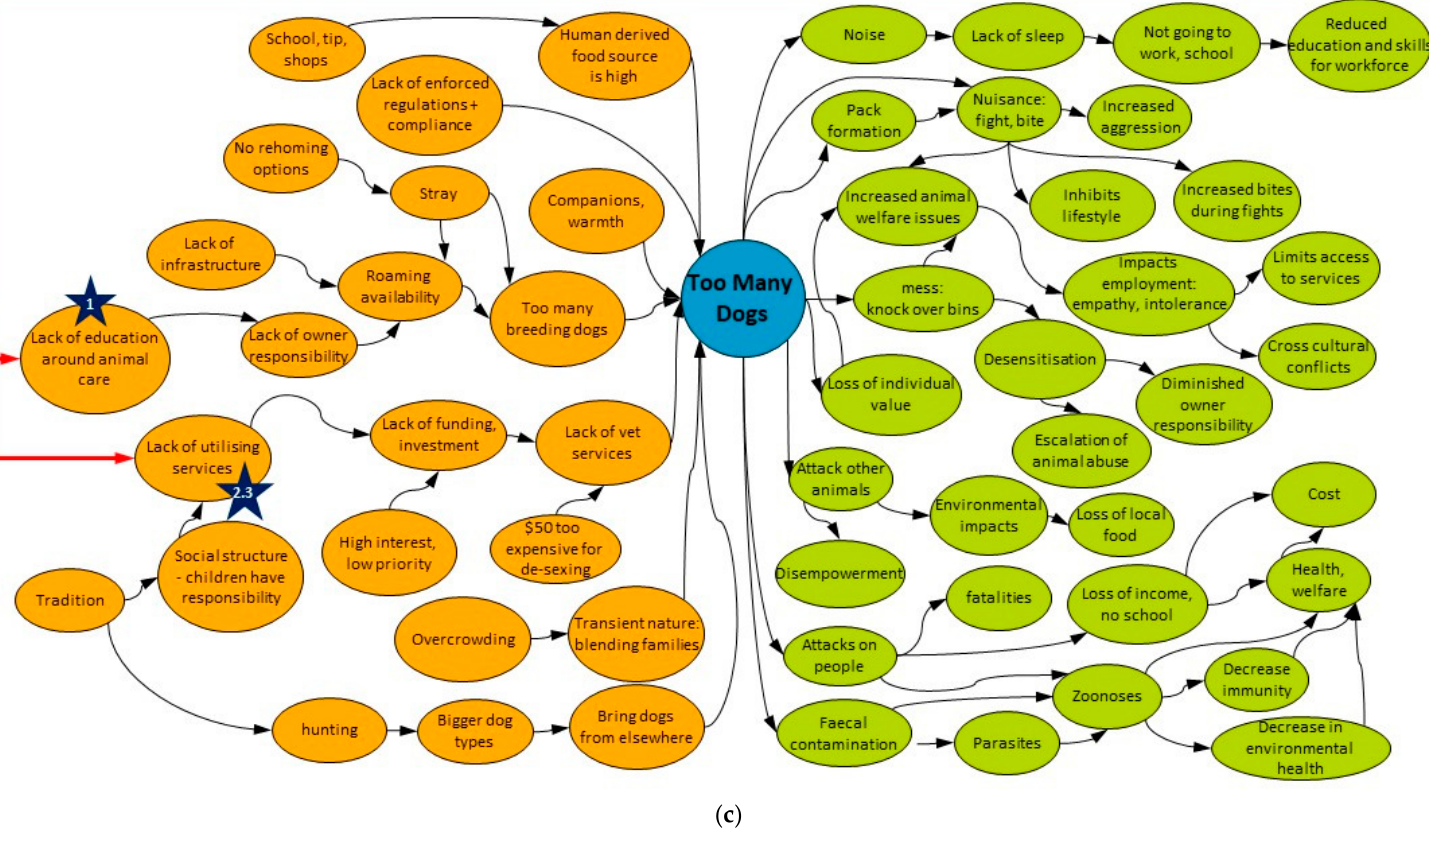
Figure 3. Causal loop analyses conducted in focus group discussions in Wurrumiyanga. The pre-determined animal management problem of “too many dogs” (i.e., dog overpopulation) was discussed by ( a ) indigenous locals (IL, Appendix A), ( b ) indigenous rangers (IR) and ( c ) animal managers (AM).